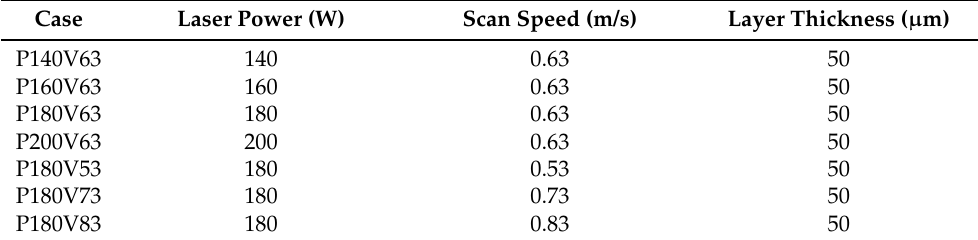
Table 5. Process parameters of the single-track cases